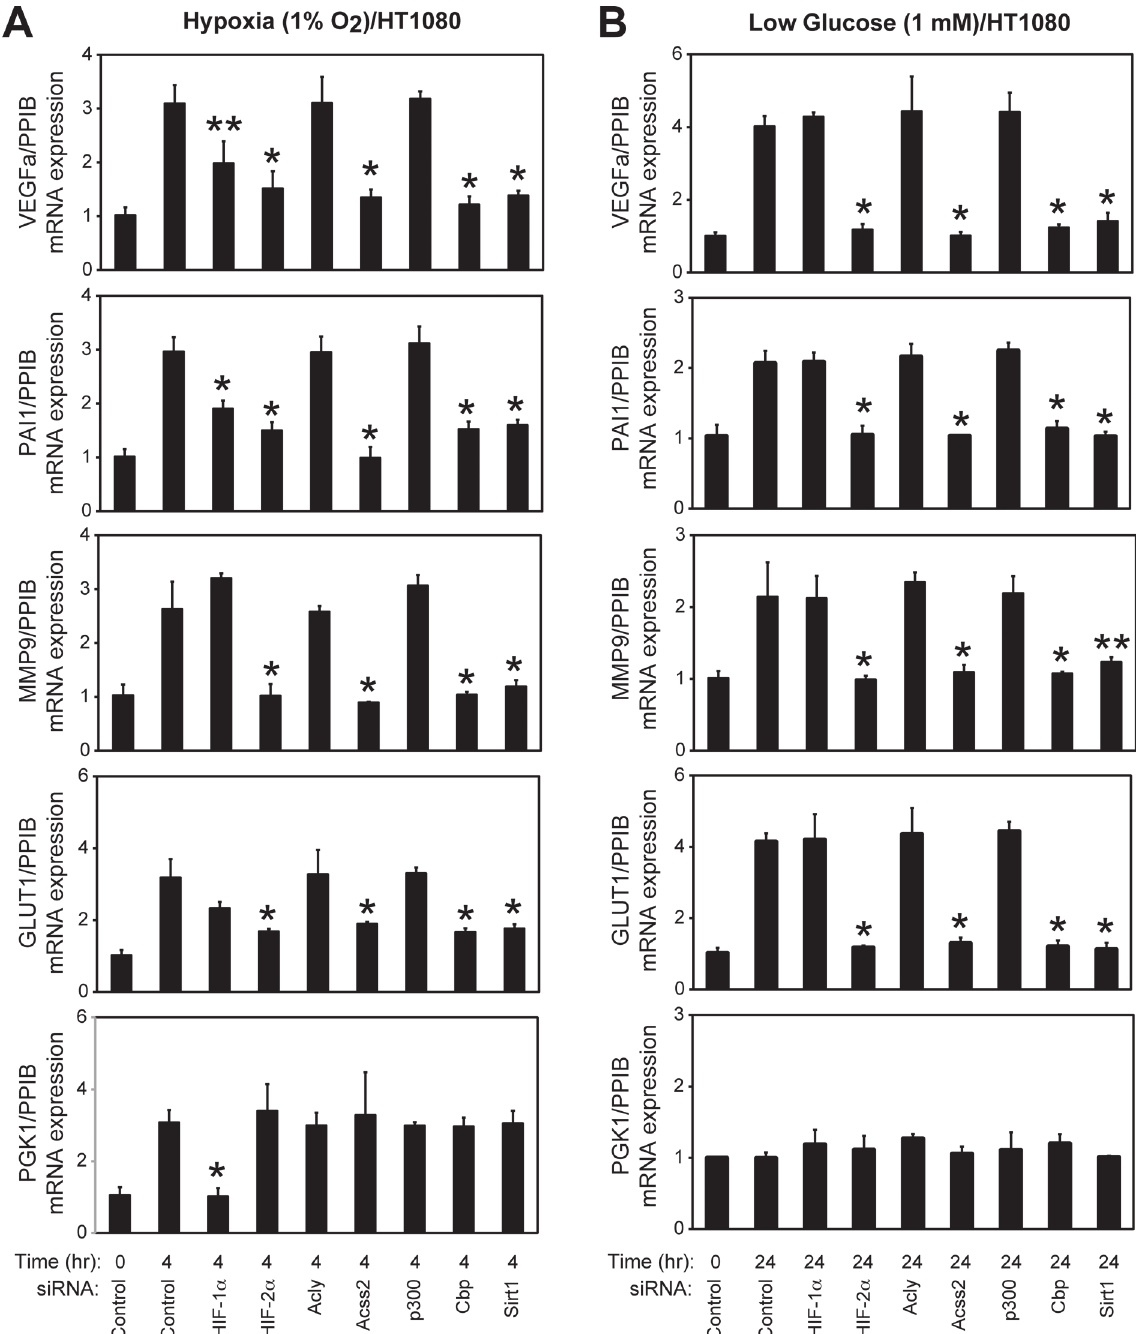
Fig 4. ACSS2, CBP, and SIRT1 are required for HIF-2 signaling. Semi-quantitative RTPCR measurement of HIF-1 selective (PGK1), HIF-2 selective (MMP9, GLUT1), or HIF-1/HIF-2 co-regulated (VEGFa, PAI1) target genes following HIF-1 α , HIF-2 α , ACLY, ACSS2, p300, CBP, or SIRT1 knockdown and after (A) early (4 hr) hypoxia exposure, or (B) after incubation under late (24 hr) low glucose conditions. Comparison by one-tailed t-test between control knockdown/treatment and specified knockdown/treatment with significant reductions compared to control indicated (single pool of triplicate biological replicates/manipulation; triplicate measurements/pool; mean/SD; * , P < 0.05; ** , P < 0.10).